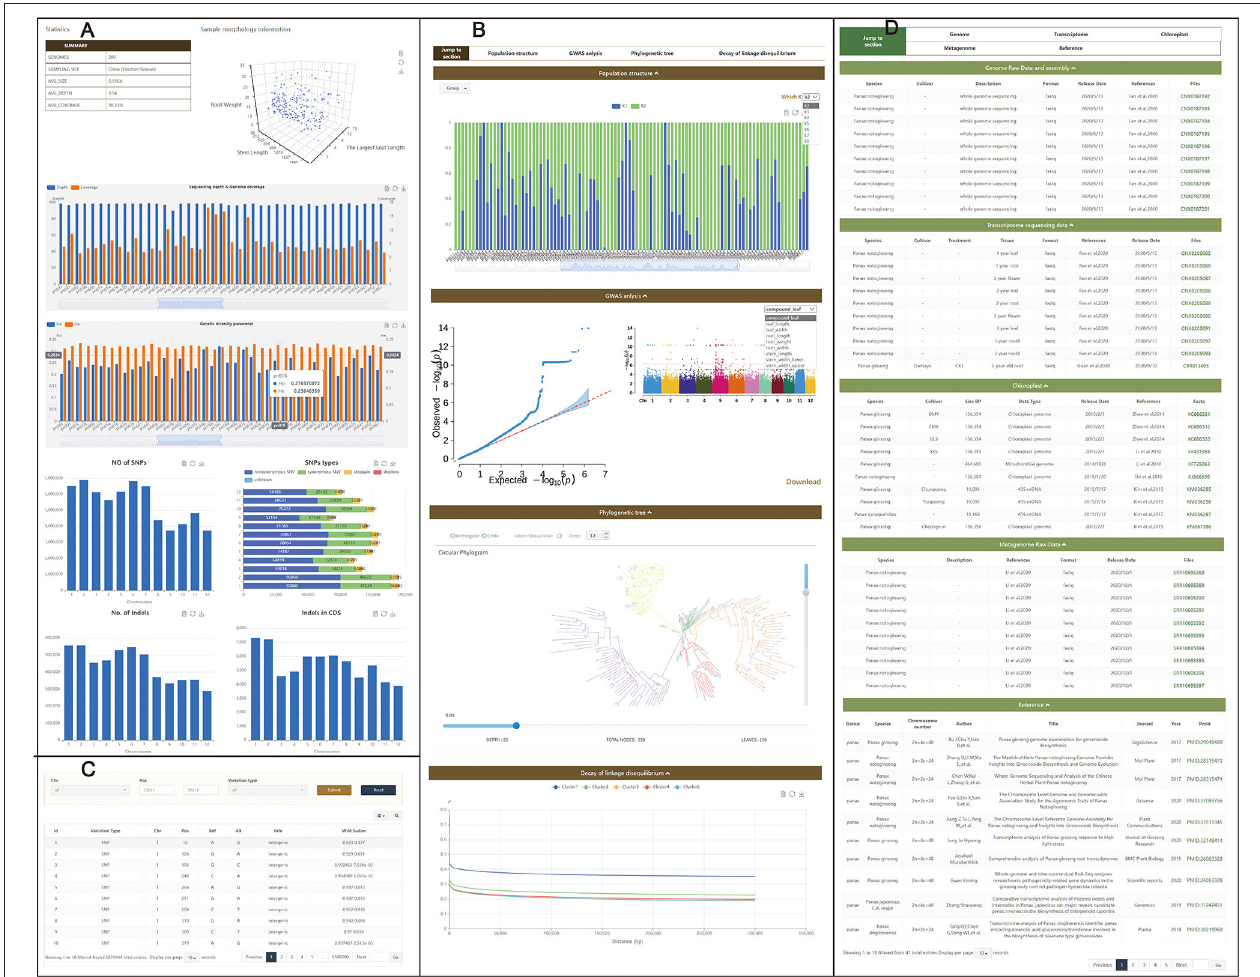
FIGURE 3 | Page on population and download. Population page contains three subpages: Statistics (A) , Analysis (B) , and Variations (C) . Download page (D) , summary and presentation of Panax omics information including transcriptome sequencing, genome, metagenome, and chloroplast genome.